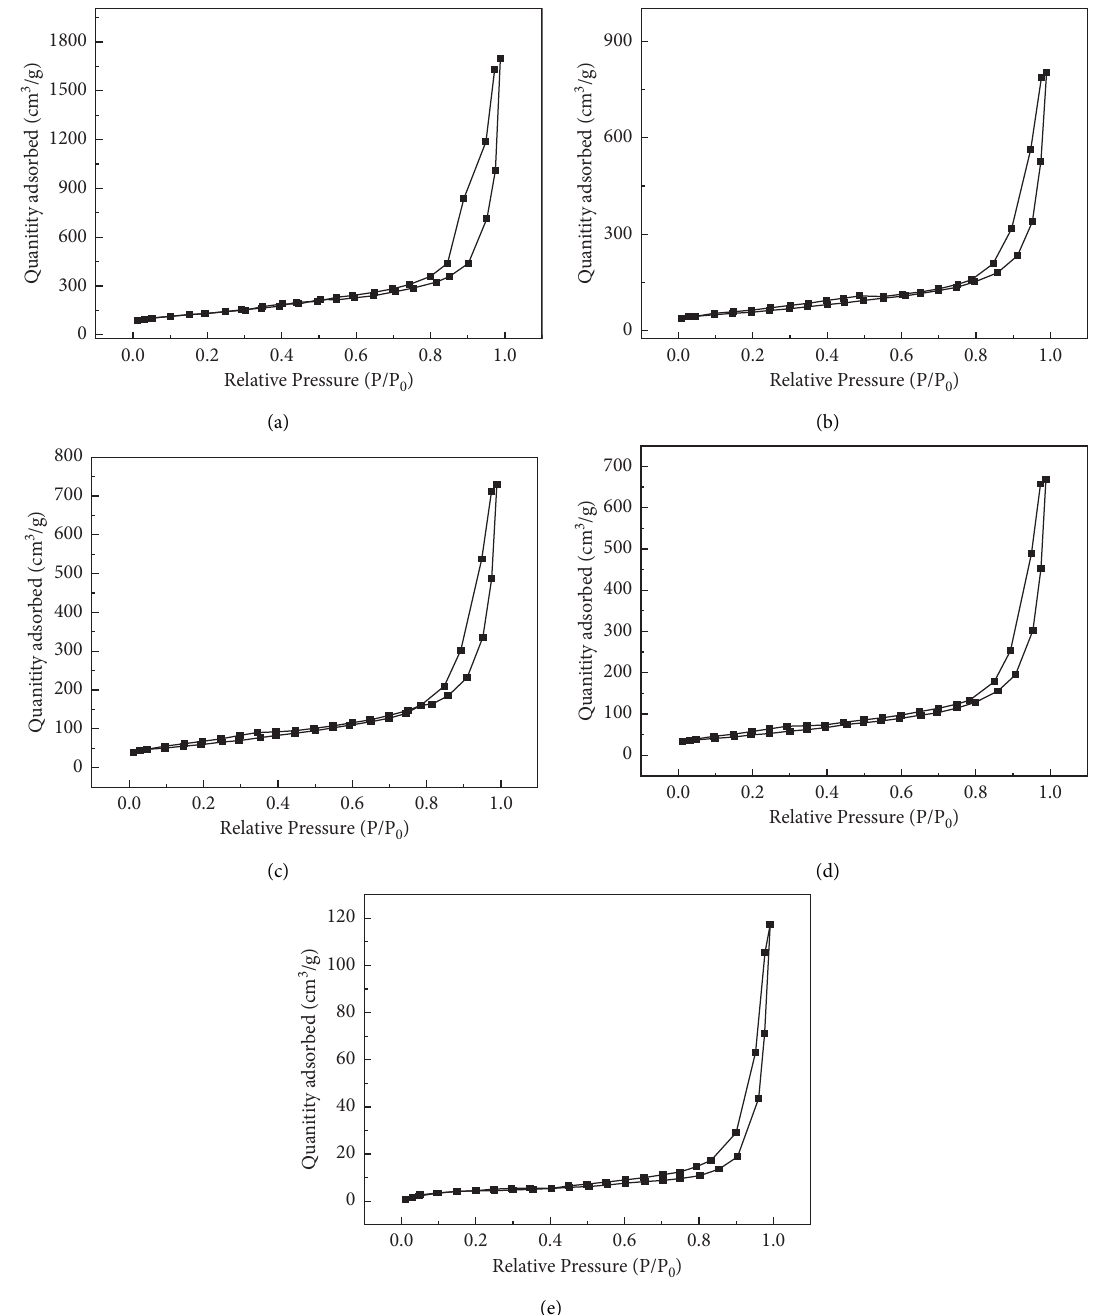
Figure 6: N 2 sorption isotherms of (a) 3D-GO-CNTs; (b) 3D-GO-CNTs-LiOH LiOH · H 2 O-3; (e) LiOH · H 2 O. Table 1: BET parameters of 3D-GO-CNTs-LiOH · H